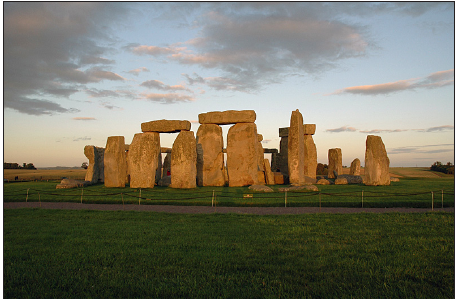
Figure 6: Stonehenge in the evening (Photo Mike Parker